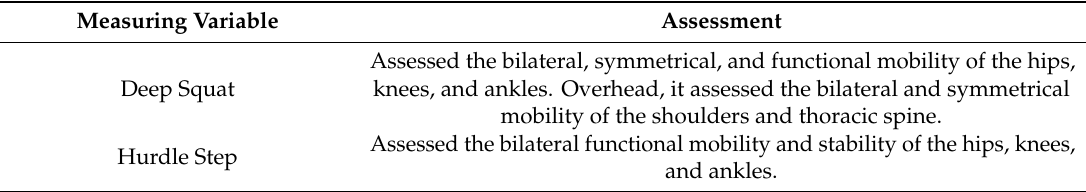
Table 1. Functional movement screen measurement variables and evaluated